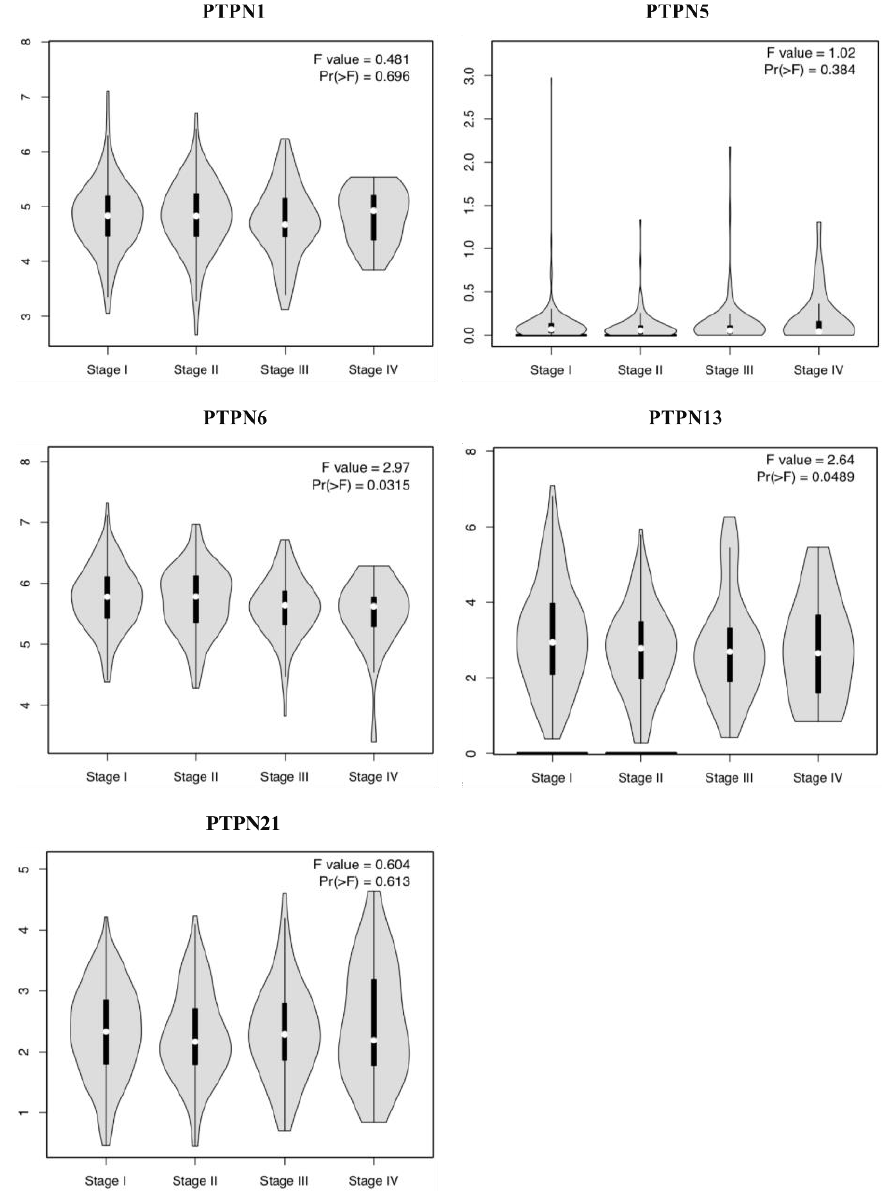
Figure 5. Correlations between expressions of protein tyrosine phosphatase non-receptor type ( PTPN ) family members and pathological stage in patients with lung adenocarcinoma (LUAD) via the GEPIA database.